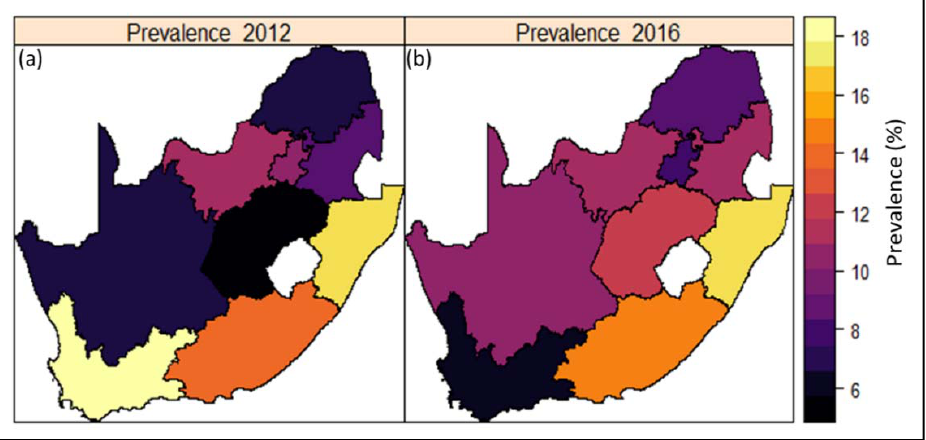
Figure 2. Estimates of crude prevalence of hypertension across the nine (9) provinces in South Africa based on ( a ) South African National Health and Nutrition Examination Survey (SANHANES) 2012 and ( b ) South Africa Demographic and Health Survey (DHS) 2016 datasets.